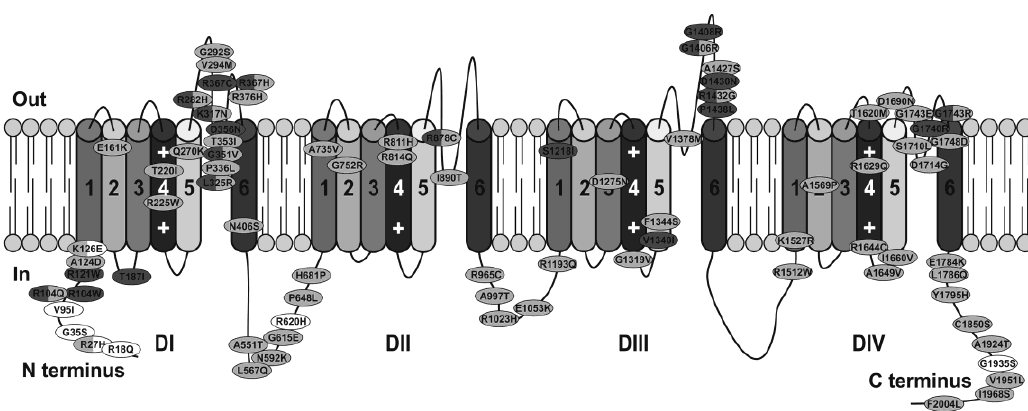
Figure 3. Na v 1.5 channel scheme showing the location of mutations in SCN5A identified in patients with the Brugada syndrome. Only missense mutations that have been functionally characterized using expression systems are displayed. Nonsense and insertion or deletion mutations are not shown. Mutations found to cause a complete loss of I Na are dark grey, those reported to reduce I Na and/or alter Na v 1.5 properties are light grey, and white indicates no changes in channel properties. Mutations for which two different types of alterations have been described are displayed in both colors.